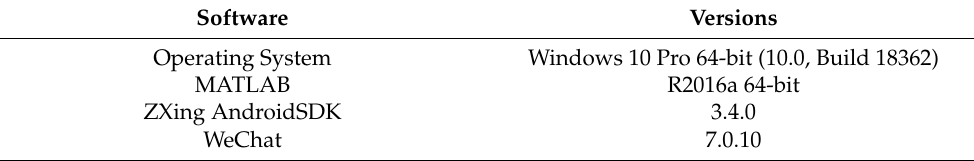
Table 3. Software